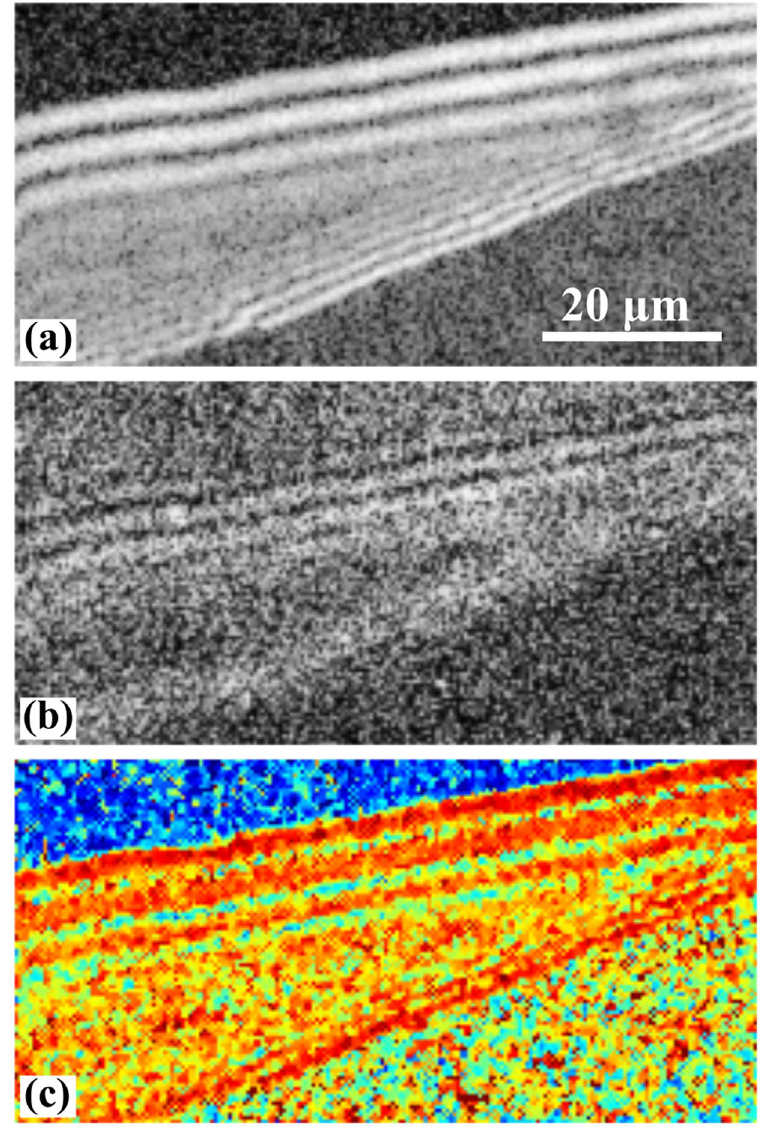
Figure 3. Anisotropy evaluation by using β computed on the same sample area as in Fig. 2. ( a ) SHG image acquired with the analyzer positioned parallel with the incident laser beam polarization. ( b ) SHG image acquired with the analyzer positioned perpendicular with the incident laser beam polarization. Histogram equalization 33, 34 is used for both images because the values in SHG intensity in the case of the analyzer positioned perpendicular to the incident polarization renders pixel values that obstruct the visualization. ( c ) Anisotropy map indicating the β values for each pixel in the